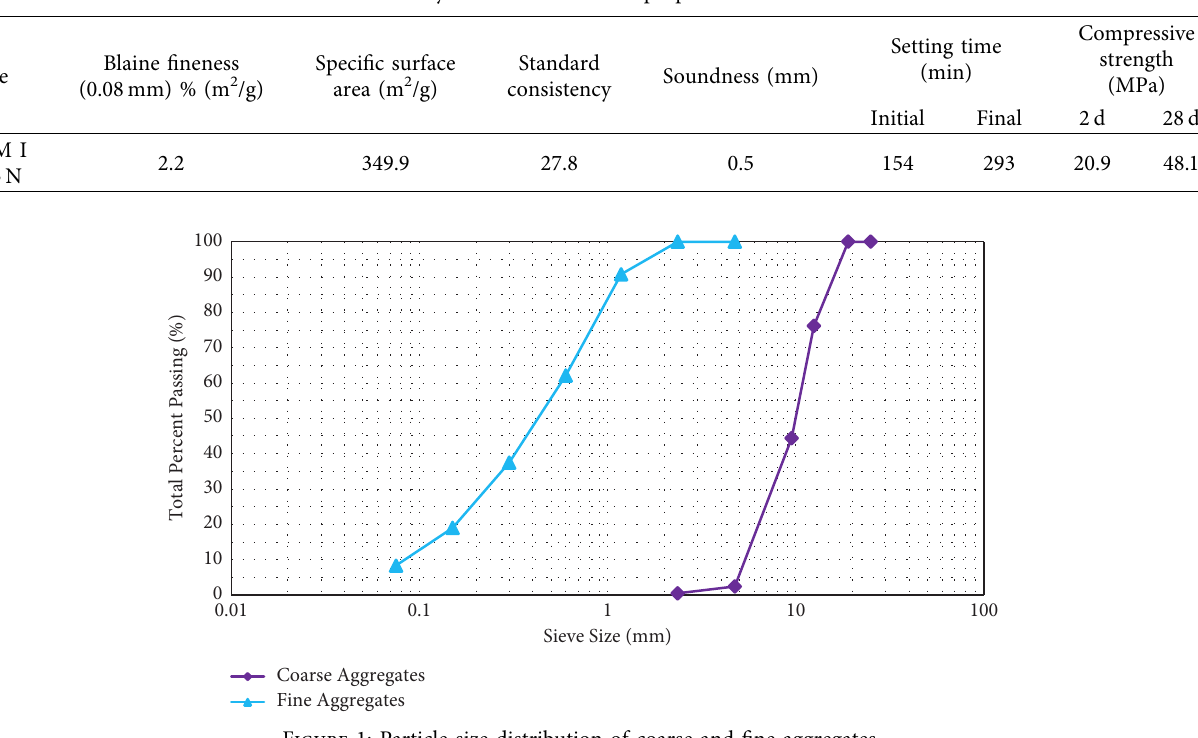
Table 2: Physical and mechanical properties of cement.